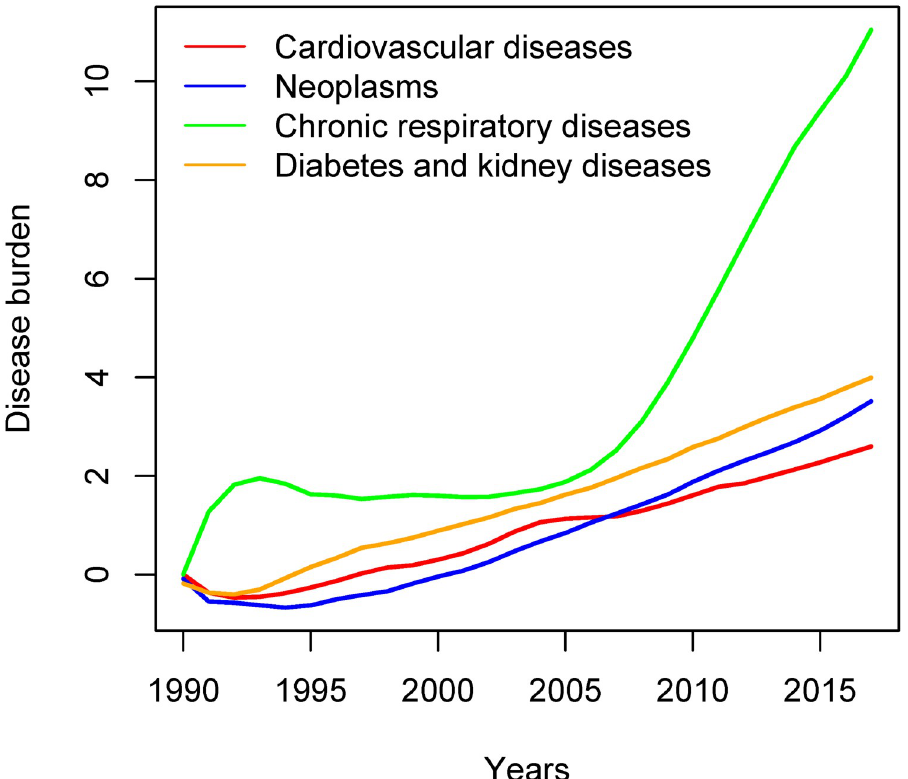
Fig 2. Particle filter estimated trajectories for the four NCDs group of